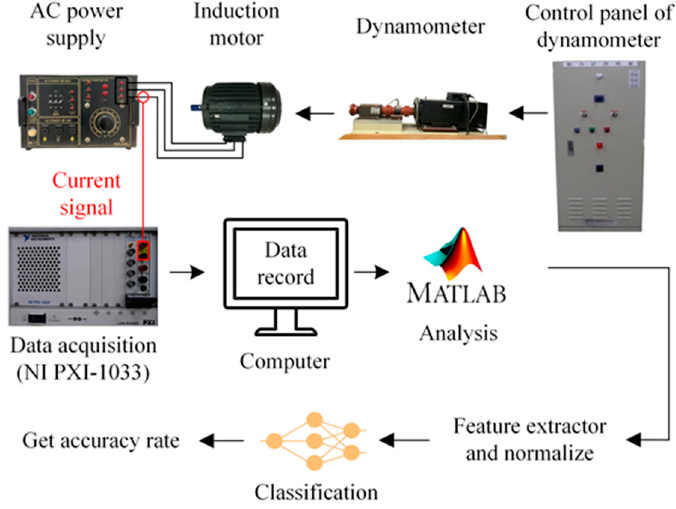
Figure 6. Experimental structure.